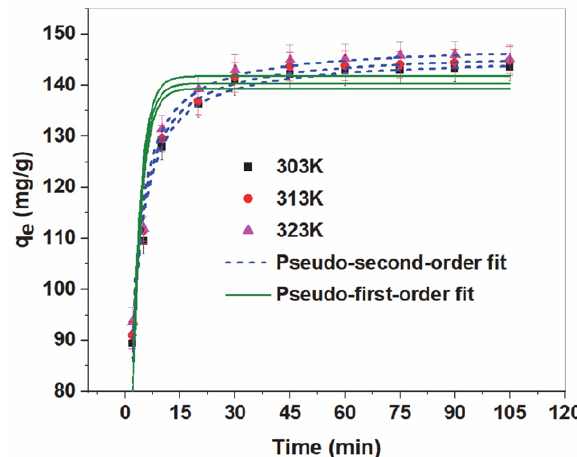
Fig. 5. Pseudo-first and pseudo-second-order kinetics for MB ad- sorption by SA-RPB at different temperatures. The experiments were conducted by 1.0 g/L SA-RPB and 150 mg/L MB at 6.5